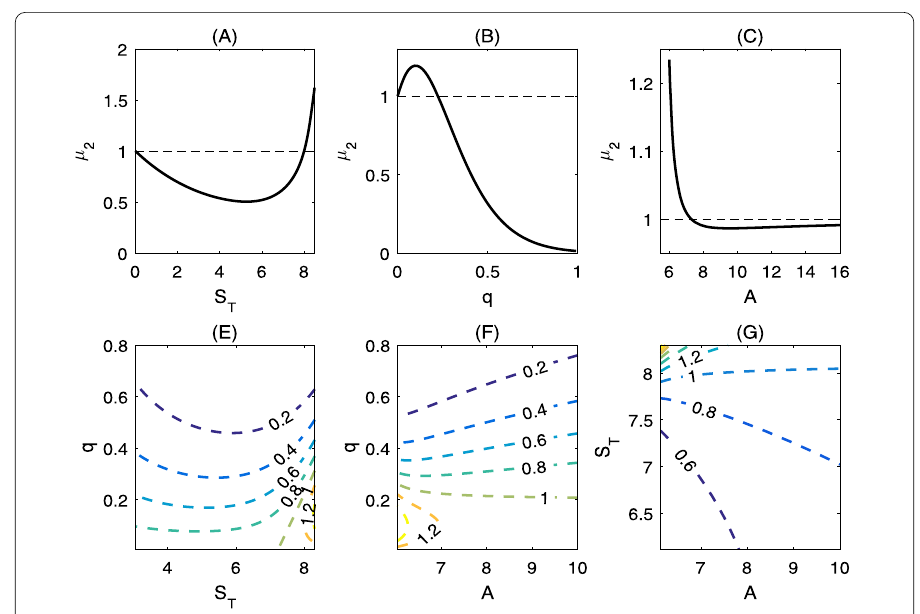
Figure 1 (A)-(C) One parameter bifurcation with respect to S T , q , and A , respectively. (E)–(G) Counter plots of μ 2 . The baseline values of all the parameters are fixed as follows: β = 1, A = 7, d = 0.7, v = 4, c = 2.5, θ = 0.1, b = 1, q =, 0.22, S T =